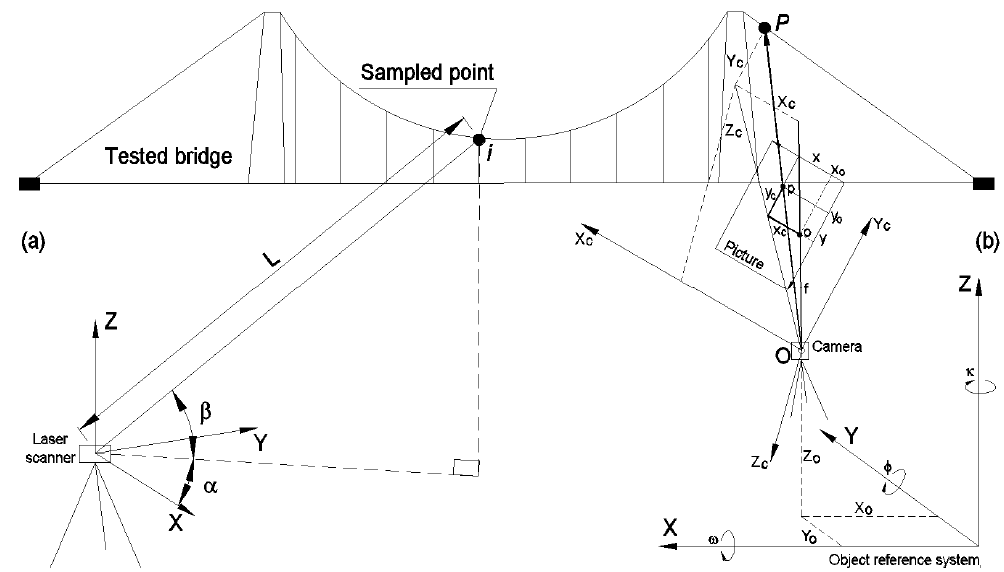
Figure 3. Operation principles. ( a ) terrestrial laser scanning (TLS); ( b ) photogrammetric techniques.